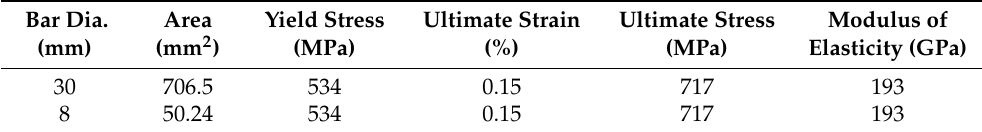
Figure 4. Constitutive material models used in FE modeling [40,41]. Table 4. Mechanical properties of steel reinforcement.